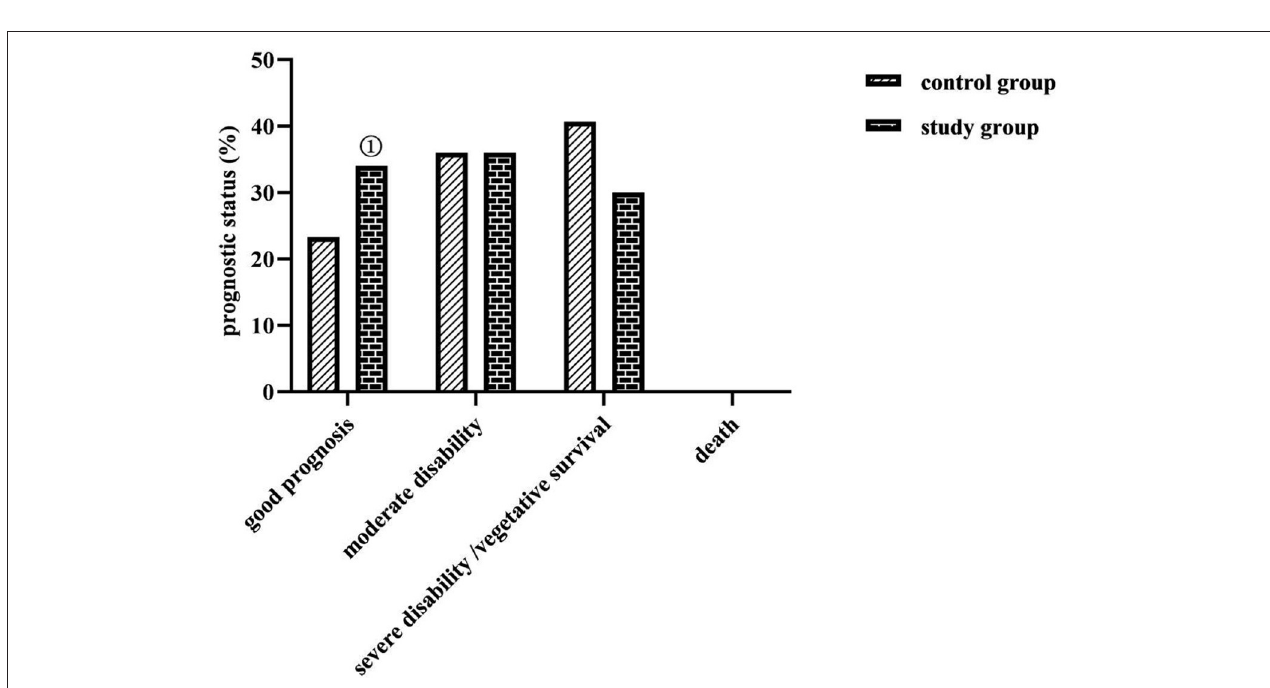
FIGURE 3 | Comparison of complication rates between the two groups ( n , %). Comparison with the control group on the same parameters,